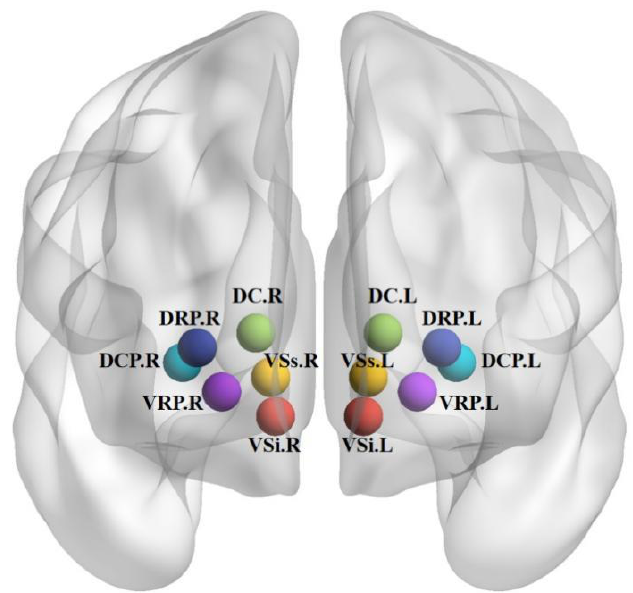
Figure 1. Definition of seeds in the striatal subregion. L, left; R, right; VSs, superior ventral striatum; VSi, inferior ventral striatum;DC, dorsal caudate; DRP, dorsal rostral putamen; DCP, dorsal caudal putamen; VRP, ventral rostral putamen.